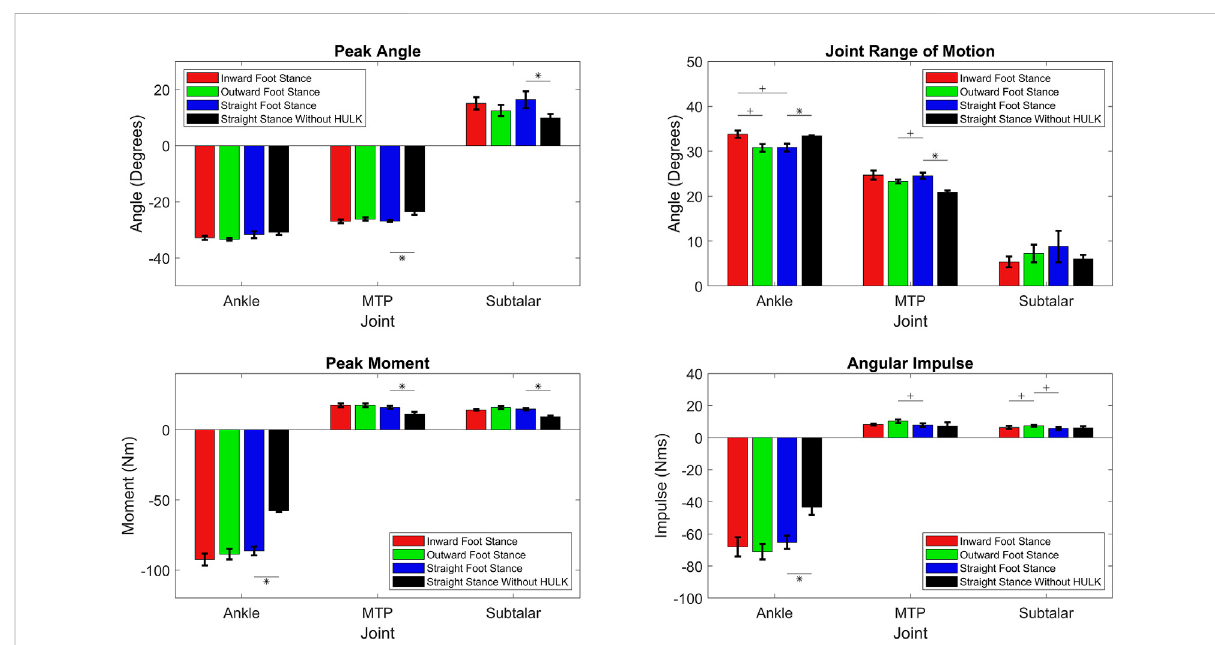
FIGURE 4 Peak angle, range of motion, angular impulse, and peak moment in each one of the three joints investigated (ankle, MTP, subtalar) for inward foot stance, outward foot stance, straight foot stance, and straight stance without HULK conditions. A “ + ” symbol indicates signi fi cant differences between an inward, outward, or straight foot stance ( α = 0.05/3), and a “ * ” symbol indicates signi fi cant differences between straight foot stance and straight stance without HULK ( α = 0.05). Data presented as average